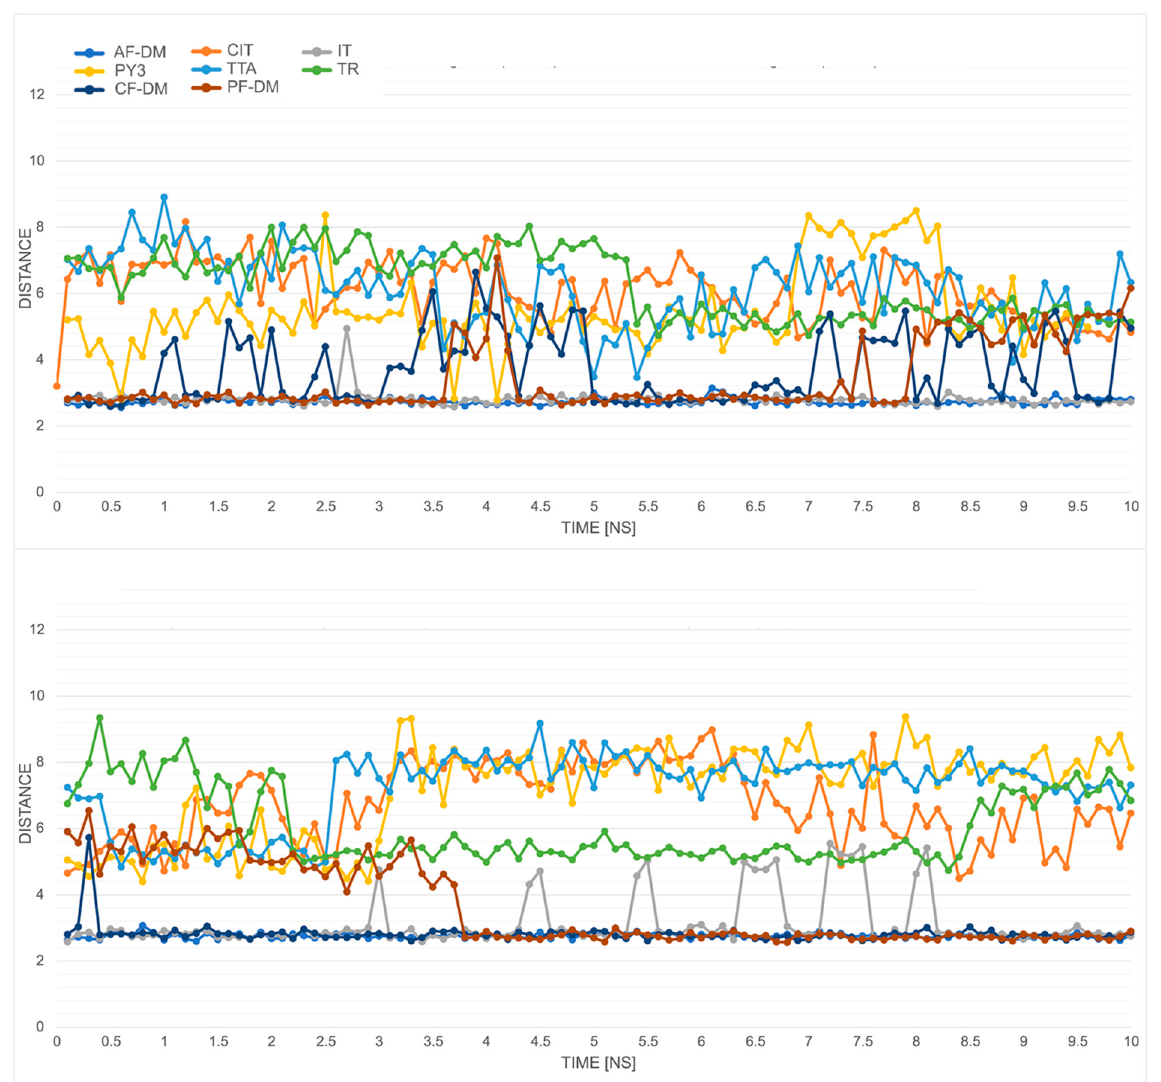
Figure 3. Changes in heteroatom-to-heteroatom distance between R119 3.50 and D118 3.49 (“aspartate cage”) for apo ( upper panel ) and CB148 complexes ( lower panel ) during the 10 ns MD simulations. For colored graphs, please refer to the online version of this paper.